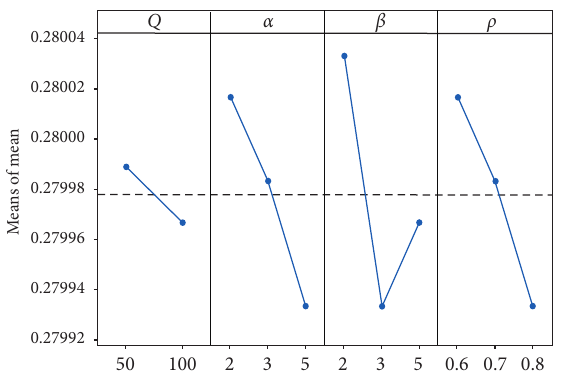
Figure 8: Mean main effect diagram.